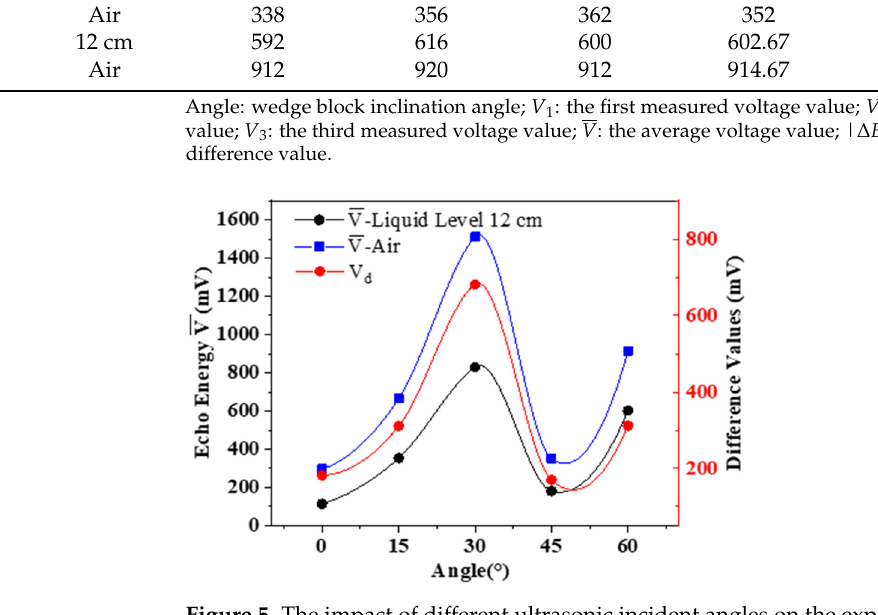
Figure 5. The impact of different ultrasonic incident angles on the experiment.